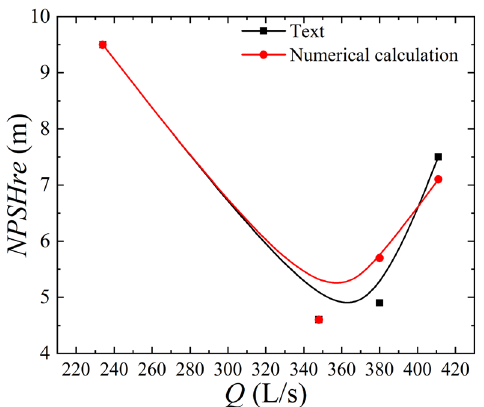
Figure 8. Comparison of the numerical calculation and the test critical cavitation margin.